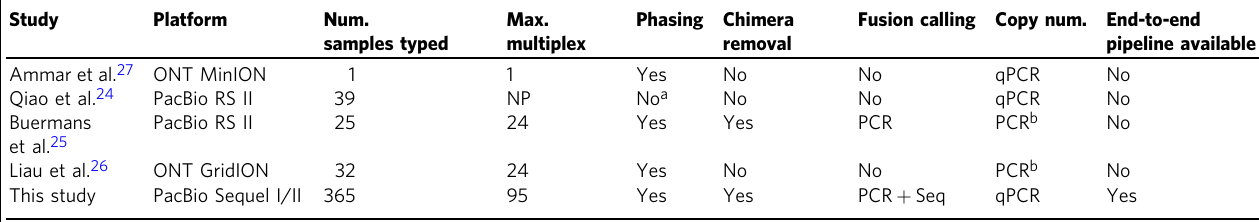
Table 1 Comparison of long-read CYP2D6 typing studies. Study Platform Num. samples typed